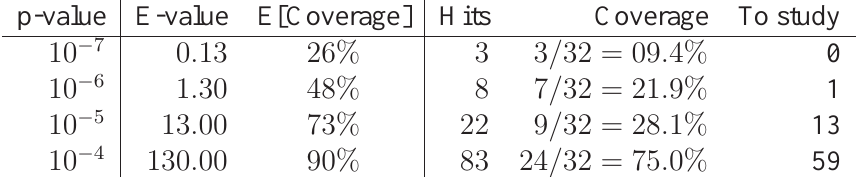
Table 1: For different p-value cut-offs, the table shows the expected number of hits due to chance (E-value) based on the effective search space size of 1.3 MB, the expected coverage of real binding sites (E[Coverage], an optimistic estimate based on the assumption that the PSSM is the correct model), the number of detected hits at this threshold (Hits), the coverage of known true binding sites (Coverage), and the remaining number of hits to investigate (To study). That number should be compared to the